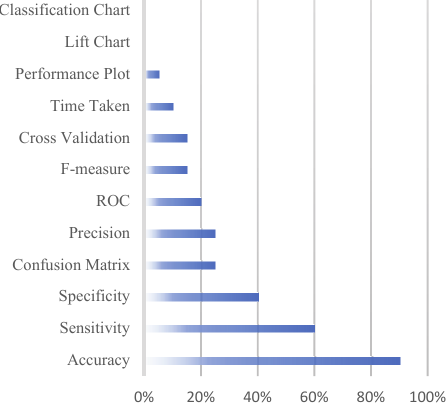
Fig. 17. Comparison of the evaluation methods